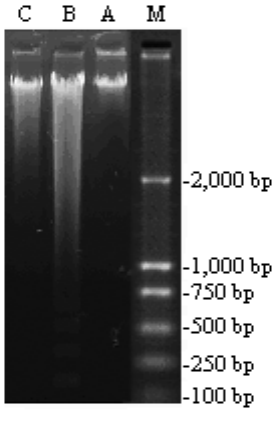
Figure 1. Agarose gel showing cell apoptosis by 60 Co γ -ray radiation and preventive effect of 5'-AMP (0.16 g/kg·bw/day) on liver tissue of radiated mice. Lanes (from left) 5'-AMP-treated group ( C ), model group ( B ), normal group ( A ), molecular weight marker ( M ).